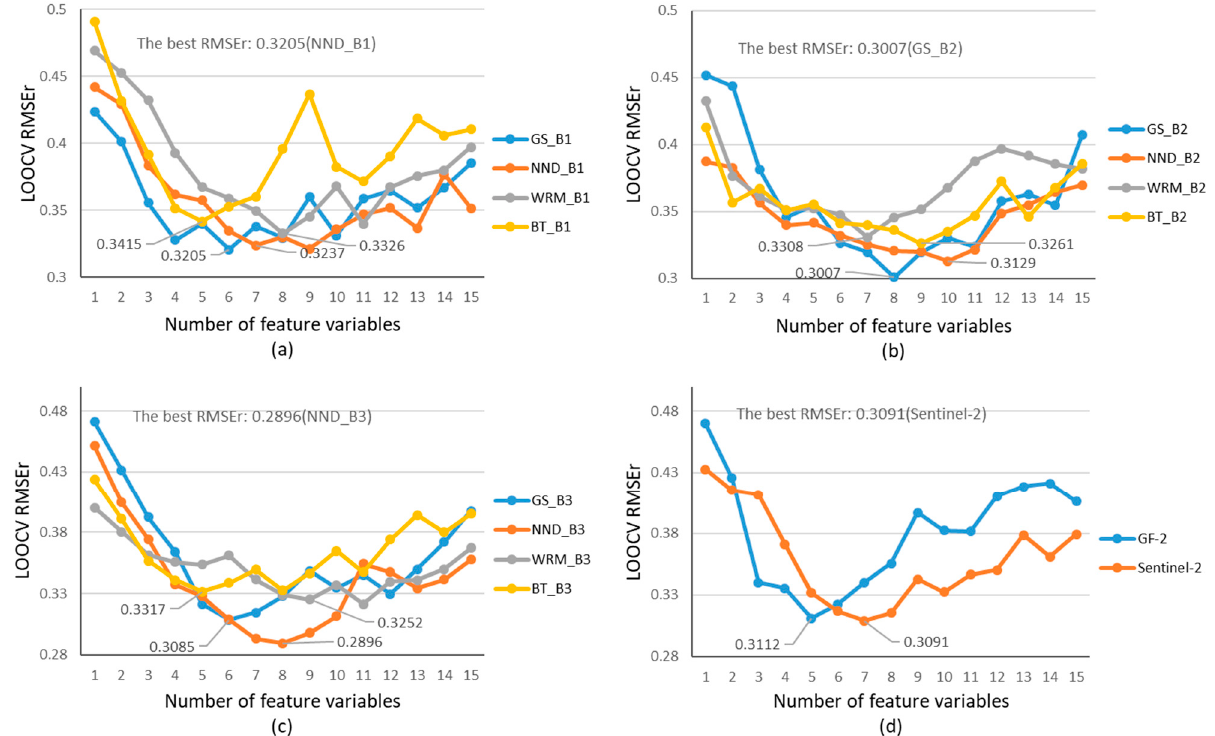
Figure A4. The optimal feature combination selected by the RF importance index and estimation RMSEr . ( a ) GS_B1, NND_B1, WRM_B1, BT_B1; ( b ) GS_B2, NND_B2, WRM_B2, BT_B2; ( c ) GS_B3, NND_B3, WRM_B3, BT_B3; ( d ) GF-2, Sentinel-2.